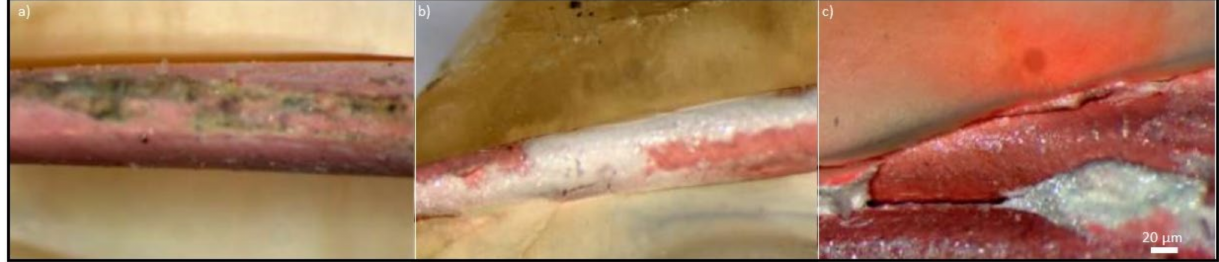
Figure 17. Leakage on the border of the root canal wall and resilon as cold filling material (LSM): ( a ) in the apical section; ( b ) an apical sealant covered with a thick intermediate layer; ( c ) on the border of the main stud and the complementary stud, resulting from the non-adhesion of the sealant to the resilon in the coronary